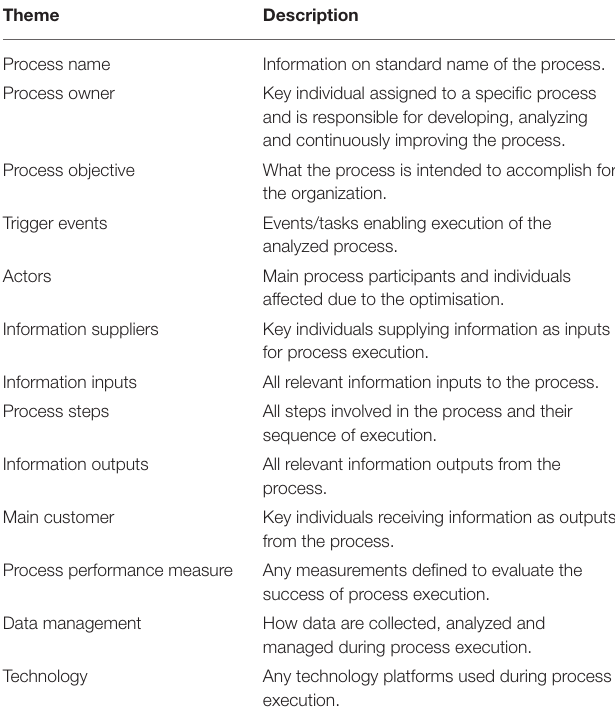
TABLE 1 | Data collection themes for As-Is process